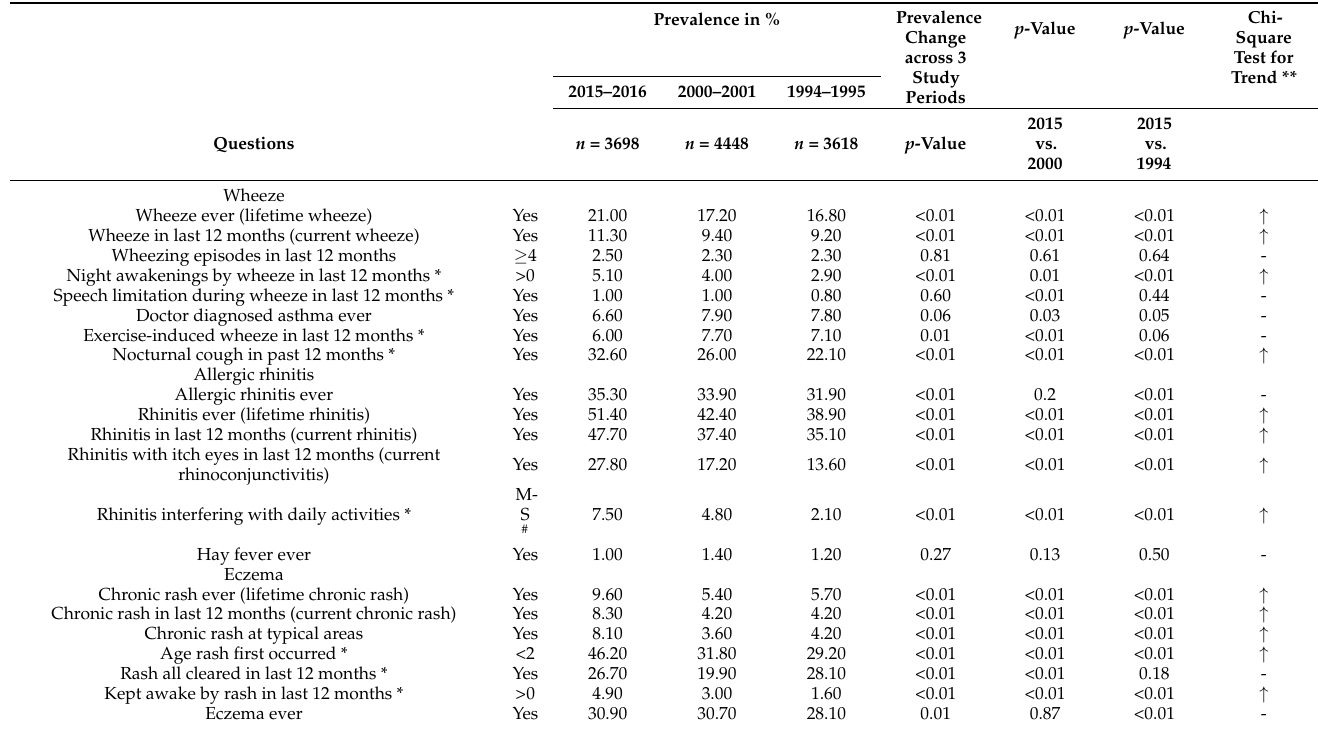
Table 1. Self-reported prevalence of wheezing, rhinitis, and eczema.